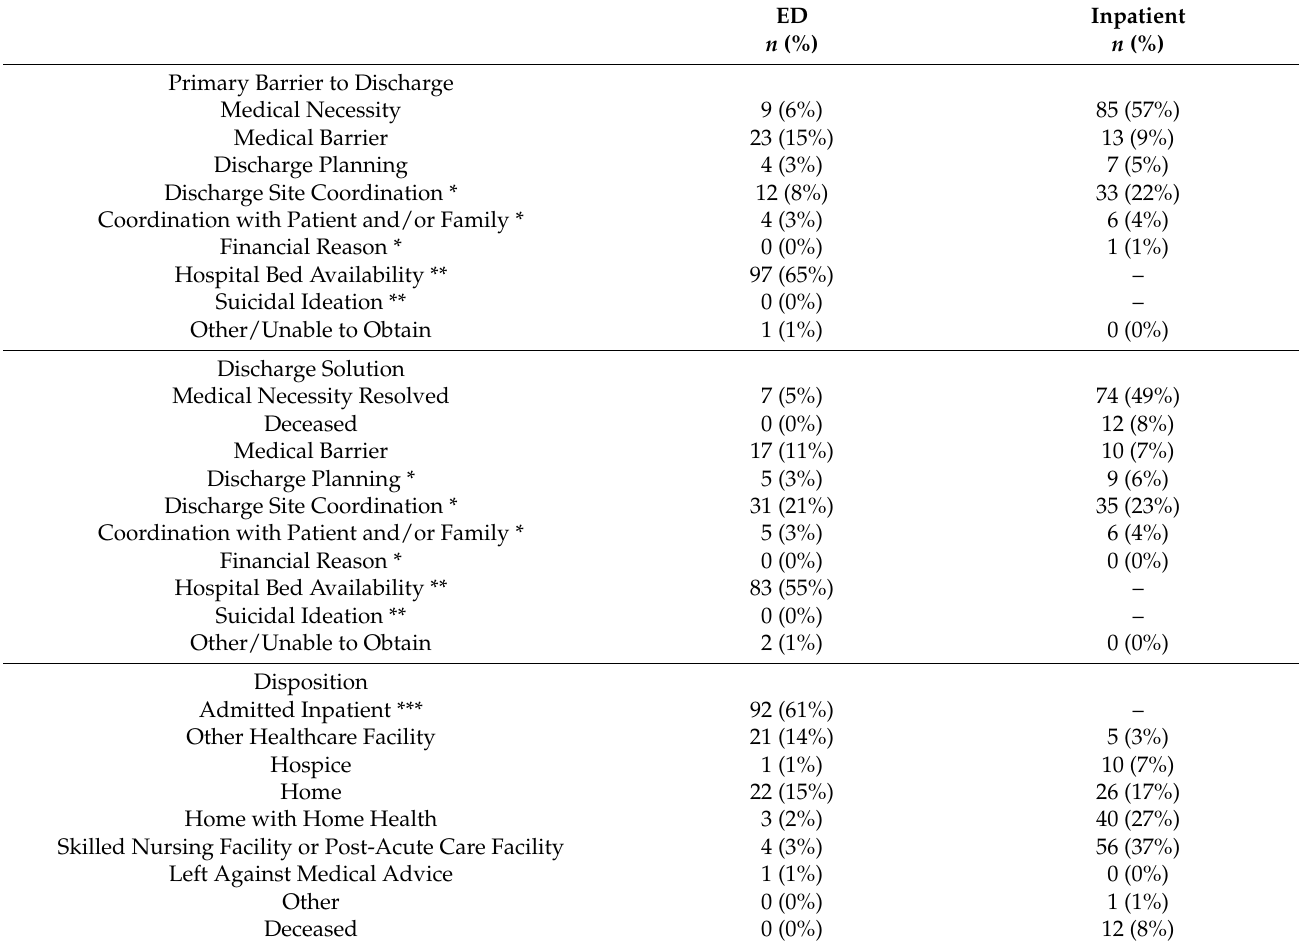
Table 3. Barriers, Solutions, and Results of LLOS Patient